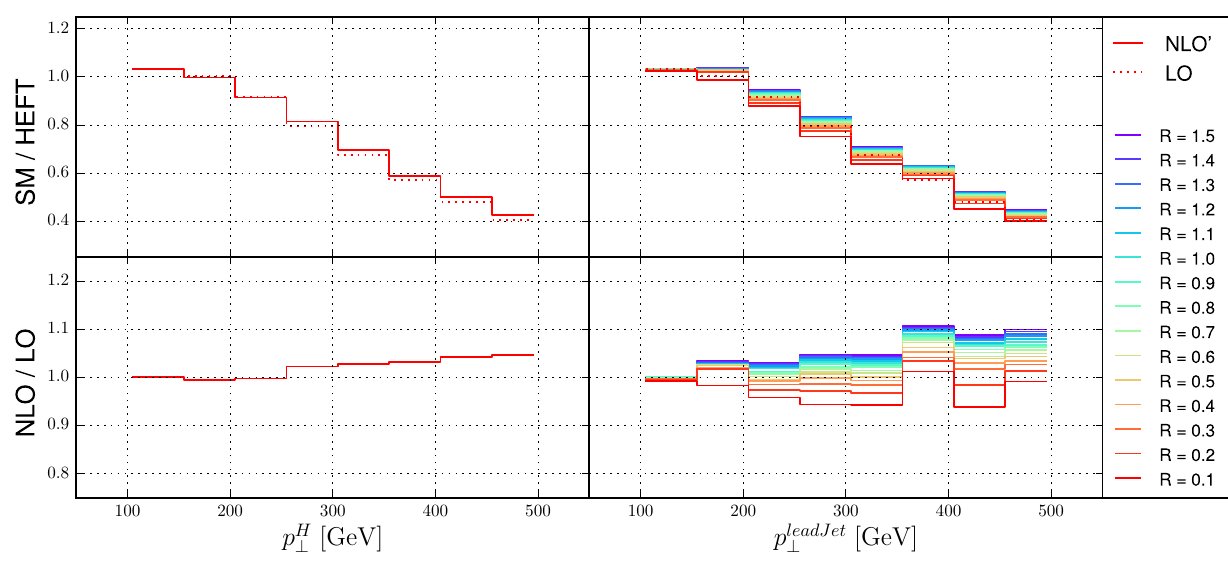
Fig. 5 The ratio between results computed in HEFT and the full Standard Model for the transverse momentum spectrum of the Higgs boson (left) and the leading jet (right) in Higgs plus jet events. Results labeled NLO’ are derived using the approximation of